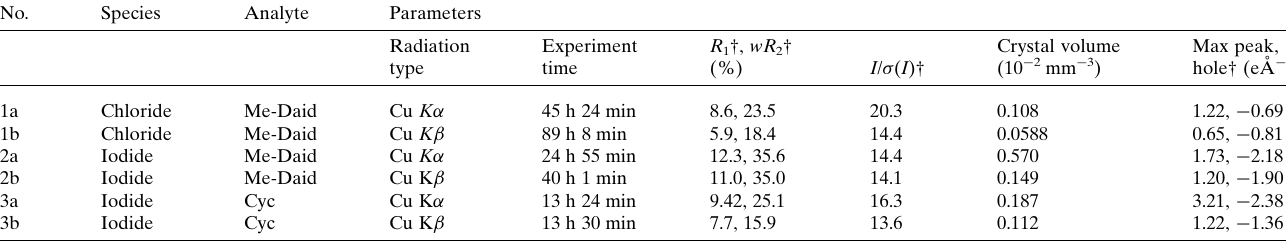
Table 1 Performed measurements and selected experiment